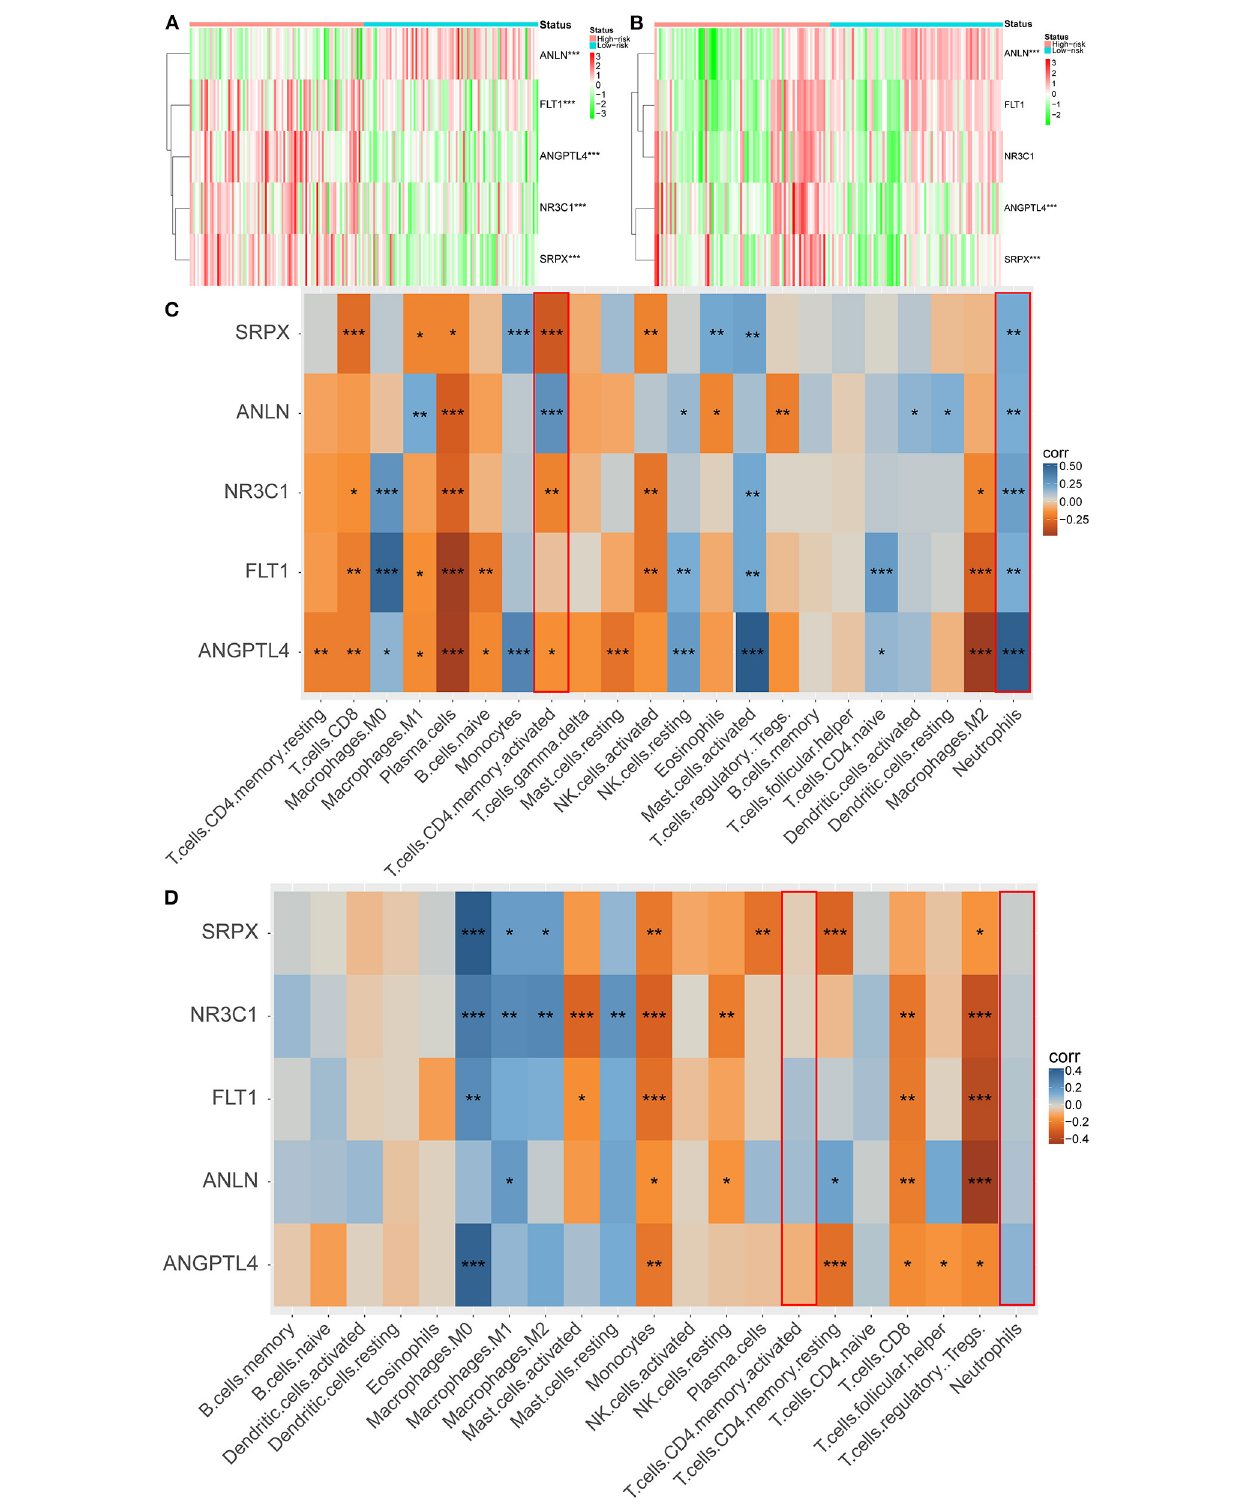
FIGURE 7 | Correlation between immune infiltration and 5 genes . Heatmap plot for expression of 5 genes between the high-risk and low-risk groups in the GEO (A) and TCGA (B) cohorts. (C,D) Heatmap depicting the correlation between 5 genes with the ssGSEA scores of 22 immune cells. * P < 0.05, ** P < 0.01, *** P < 0.001.